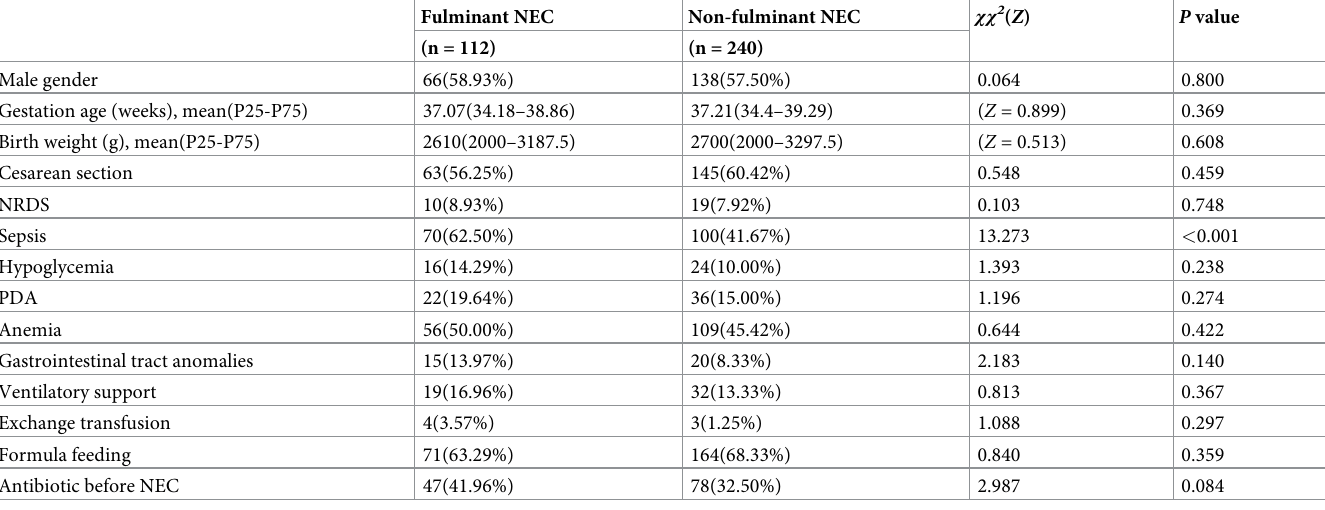
Table 1. Demographic features and risk factors of the NEC